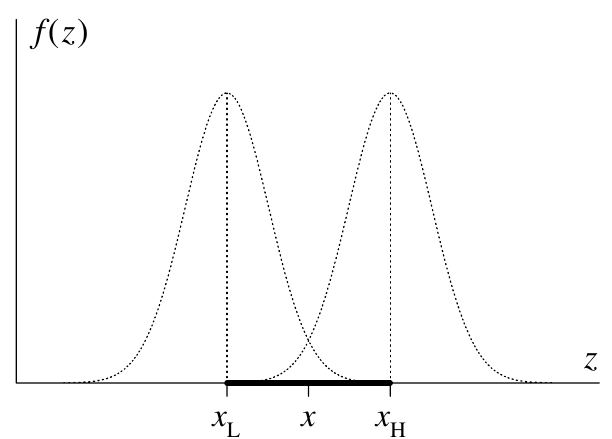
Fig. 2. An evaluated 95% confidence interval [ x L , x H ] = [ x − 1 . 96 σ, x +1 . 96 σ ] for θ when the measurement result x is drawn from a normal distribution with mean θ and known standard deviation σ . Fig. 3. An evaluated 95% confidence interval [ x L , x H ] for θ when the measurement result x is drawn from a uniform distribution with lower limit 0 and upper limit θ . (The figure is not drawn to